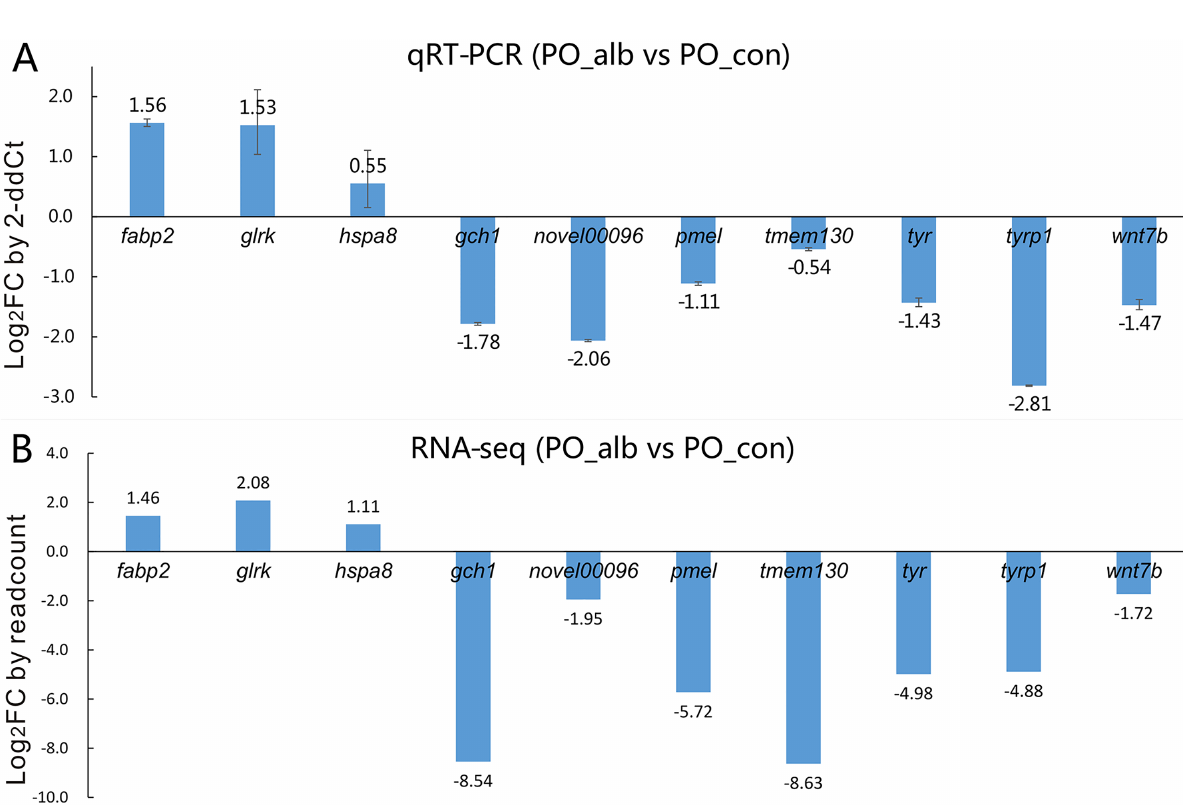
Fig 2. The expressionlevels of ten genes in qRT-PCR and RNA-seq. The expressionfold change(FC) 10 P . olivaceus genesin PO_alb versus PO_con detected by qRT-PCR and RNA-seq were calculatedby 2-ddCt and readcount,respectively.And these genes’ log2FC values of qRT-PCR and RNA-seq are shown in A and B, respectively.In qRT-PCR analysis, β -actin expressionlevels were used for the internalcontrol, and values are indicatedas means ± standarderror (SE) derived from triplicate experiments.